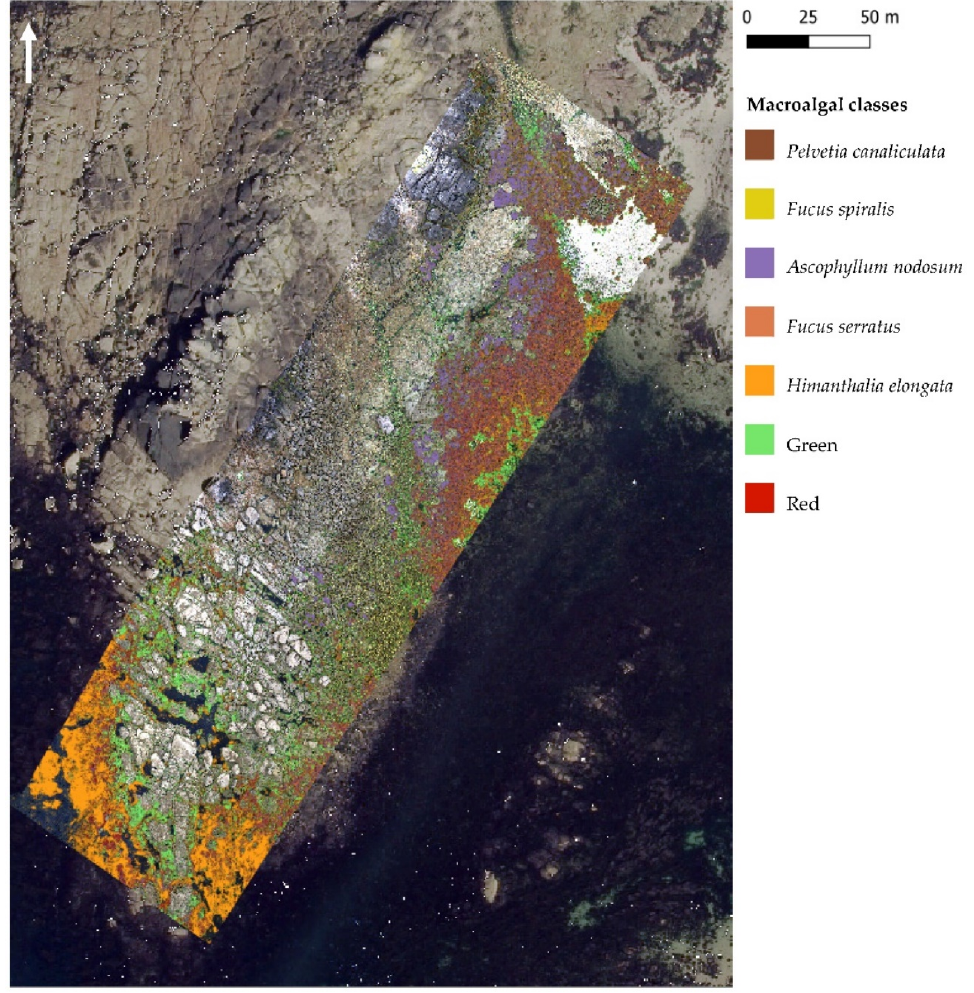
Figure 8. Spectral angle mapper (SAM), trained using image-derived spectra resulting from the hyperspectral UAV survey at Porspoder. Seven macroalgal cover classes are displayed over the UAV RGB imagery and an orthophotography (Mégalis Bretagne et collectivités territoriales bretonnes— 2015), giving an overview of the site. The ‘Substratum’ and ‘Water’ classes are not represented on the map. Class codes ‘Green’ and ‘Red’ represent grouped green and red macroalgal species, respectively. Table 5. Spectral angle mapper (SAM) confusion matrix, calculated, using ENVI 5.6.1, by comparing pixels of known class locations to those predicted by the classification workflow, for each of the nine cover classes. Results are displayed as percentages of pixels assigned, correctly or incorrectly, to each class. User/producer accuracies (User Acc. and Prod. Acc., respectively) are also